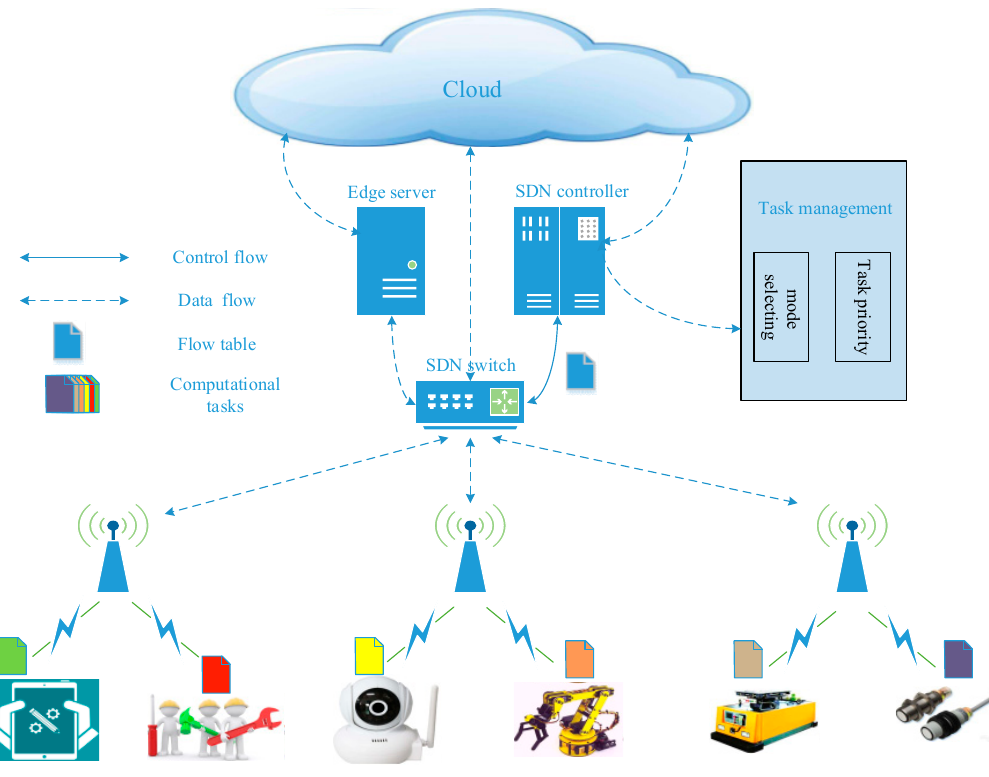
Figure 1. System architecture of Software ‐ Defined IIoT based on fog computing in a smart factory.